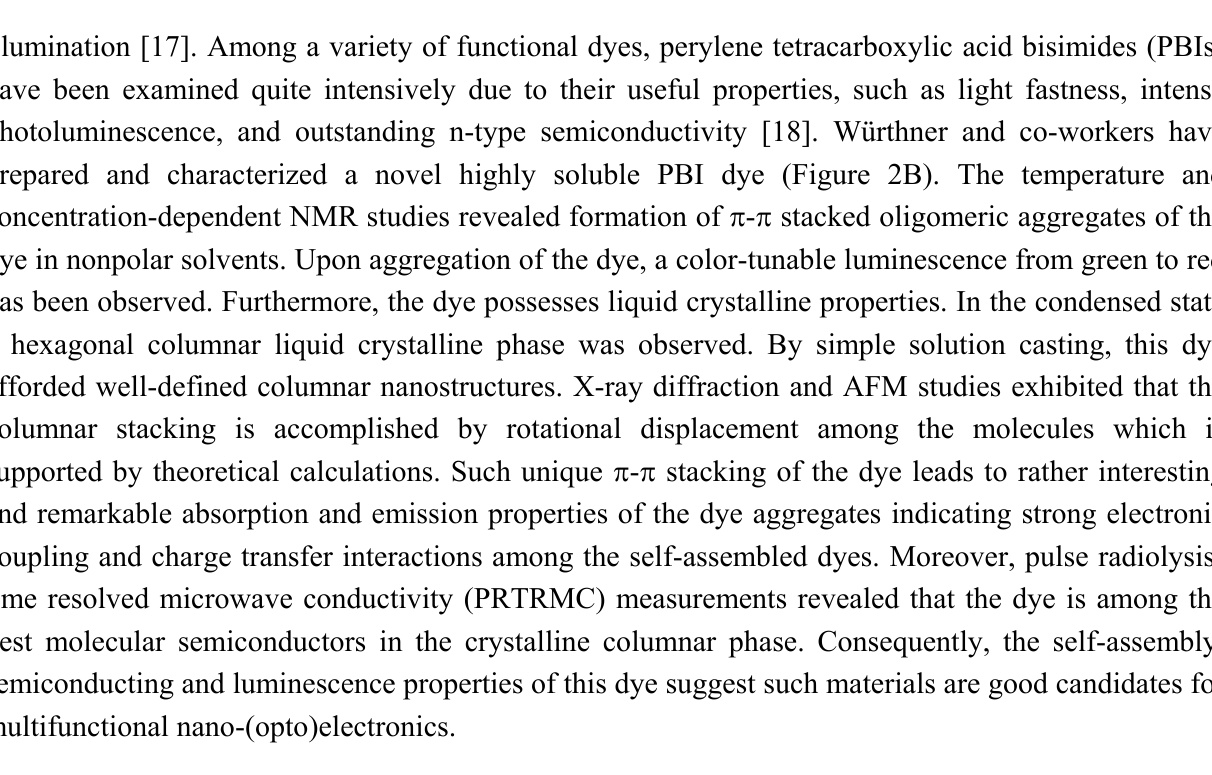
Figure 3. Aggregate structures of perylene bisimide upon hydrgen bonding